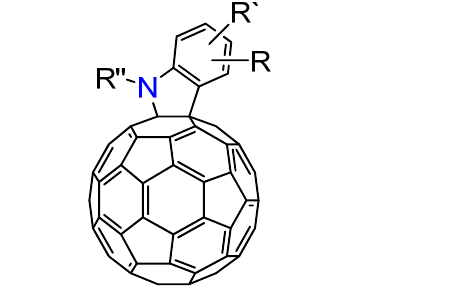
Table 5. Catalytic activities of acidic compounds on formation of 5-dodecylindolino[60]fullerene.